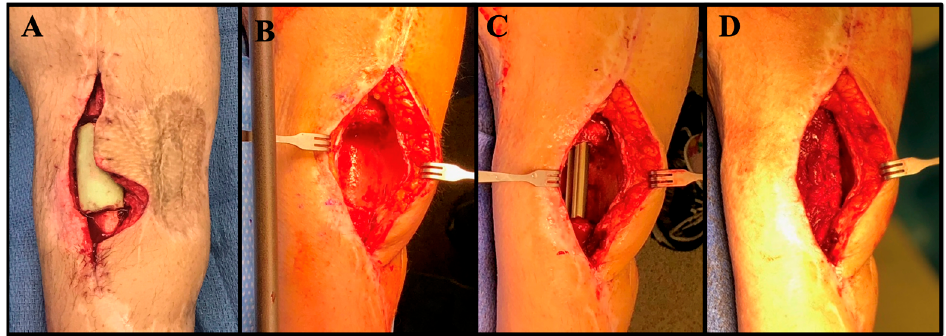
Figure 4 . Clinical images of the same patient are shown at the time of antibiotic spacer placement ( A ), spacer removal ( B ), nail placement ( C ), and bone grafting ( D ).